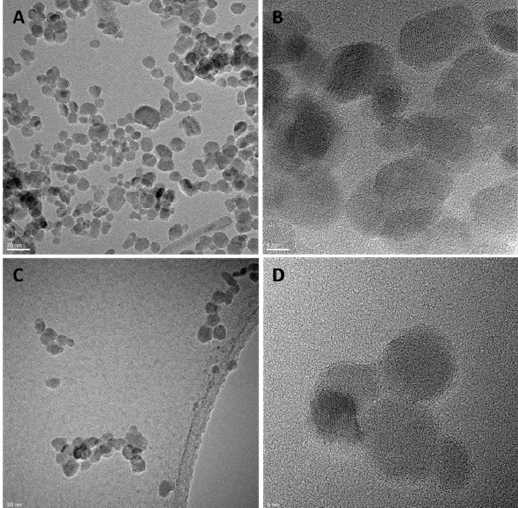
Figure 2. TEM and HR-TEM images of nanoparticles coated with PEG (Mw: 550), ( A , B ), and PEG (Mw: 2000), ( C , D ), respectively.